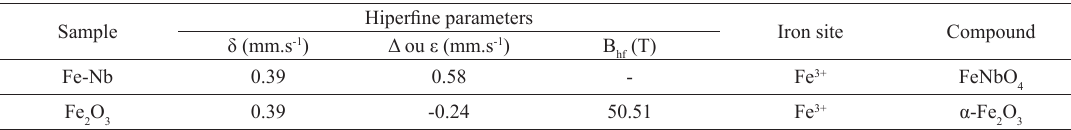
Table 1. 57 Fe Mossbauer parameters for Fe-Nb at room temperature. Sample